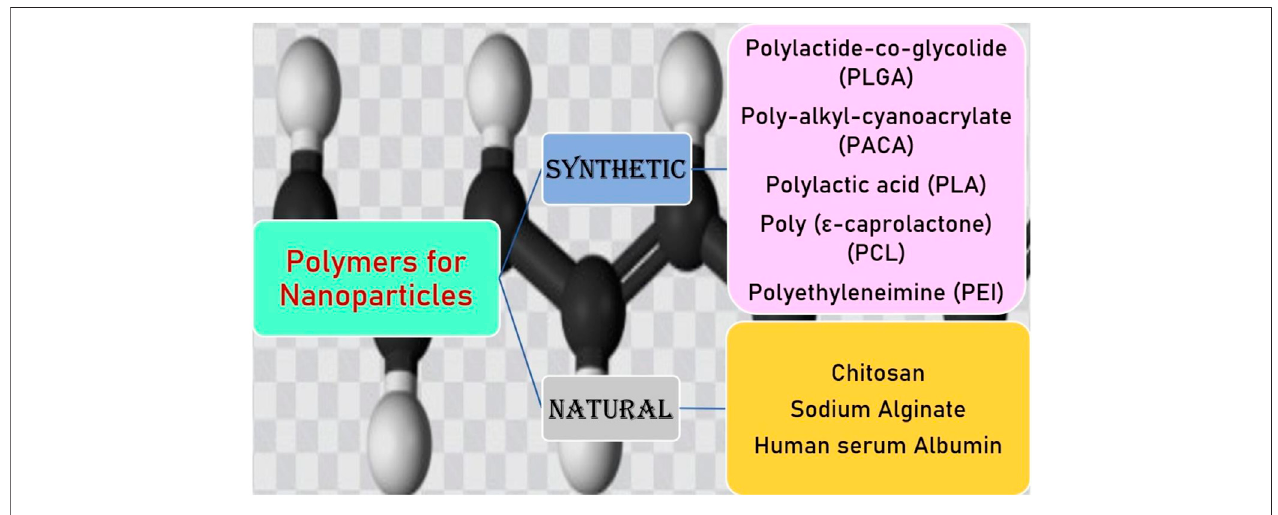
FIGURE 2 | Types of polymers used for NP preparation for brain targeting. NP, nanoparticle.